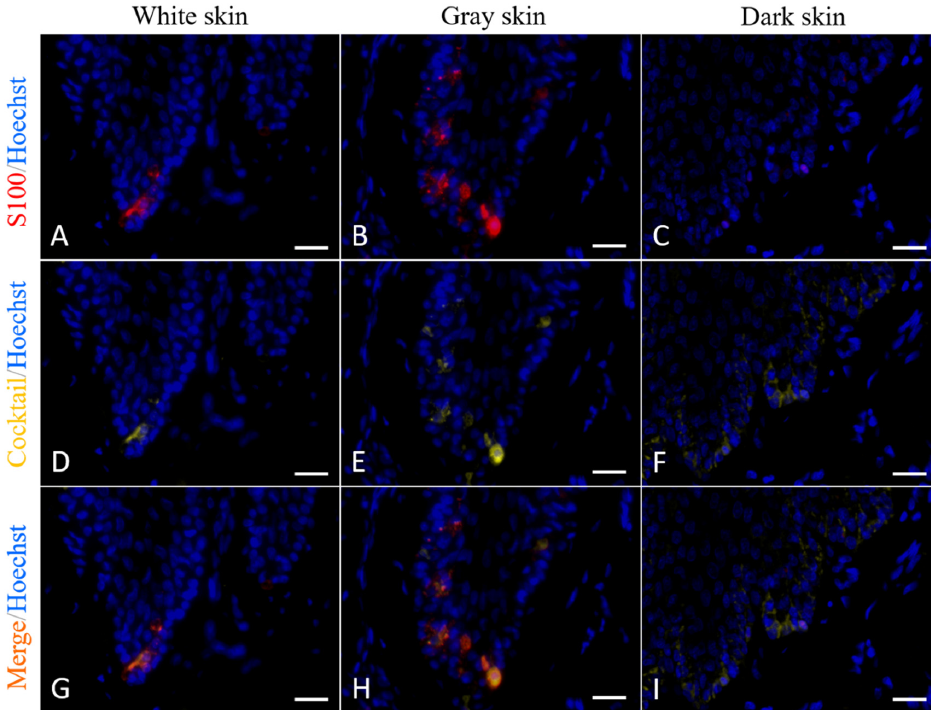
Figure 5. Immunofluorescence staining with anti-S100 antibody and cocktail antibody in normal white/gray/dark skin of Fraser’s dolphins. Signals color: red, S100; yellow, cocktail; blue, Hoechst. Scale bars = 20 μ m. ( A – C ): IF staining with anti-S100 antibody. ( D – F ): IF staining with cocktail antibody. ( G – I ): Dual staining with anti-S100 and cocktail antibodies.